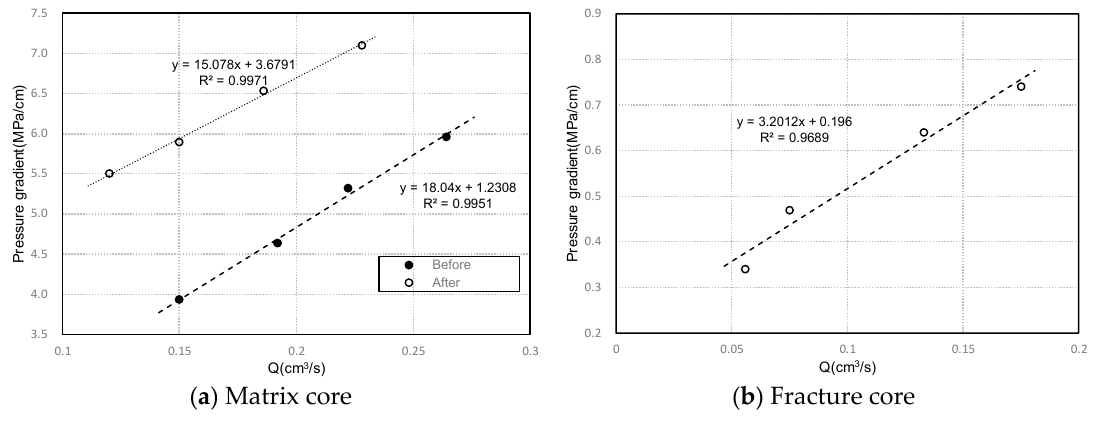
Figure 9. Comparison of starting pressure before and after water injection.